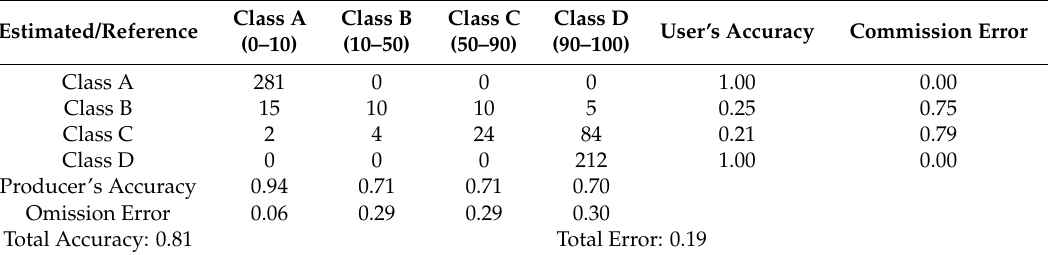
Table 6. Confusion matrices for Kenttärova ground camera.